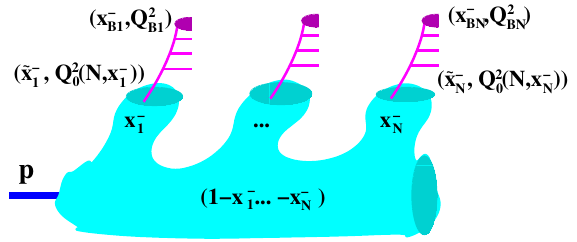
Figure 2. Schematic view of the Pomeron generation on the tar- get side of a pp interaction. In brackets are the momentum frac- tion and virtuality of the parton at the beginning (˜ x , Q 2 the end ( x B , Q 2 ) of the DGLAP evolution. B